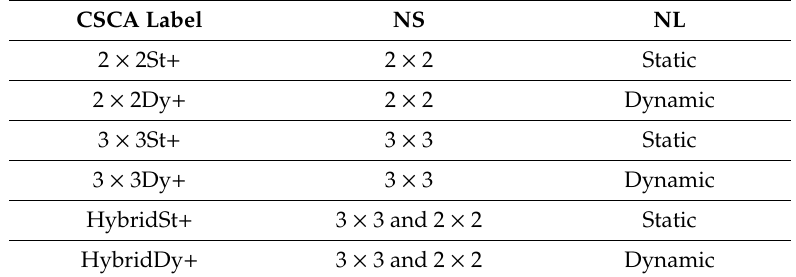
Figure 2. The Hybrid CSCA works by first constructing a 3 × 3 search area according to the rules of the Neighbourhood locality (NL) type to which it belongs. Next it constructs 4 overlapping 2 × 2 sub-search areas within the initial 3 × 3 search area. The total charge in each sub-search area is compared, with the highest total being assigned to the output. In this example, assuming all stars represent the same amount of charge, the green search area (top right) would determine the output as it contains the highest total charge (4, compared with 3 for yellow (bottom right) and red (top left), and 2 for the blue (bottom left)). Table 2. A list of the di ff erent CSCAs used in this work along with their NS and NL categories. CSCA